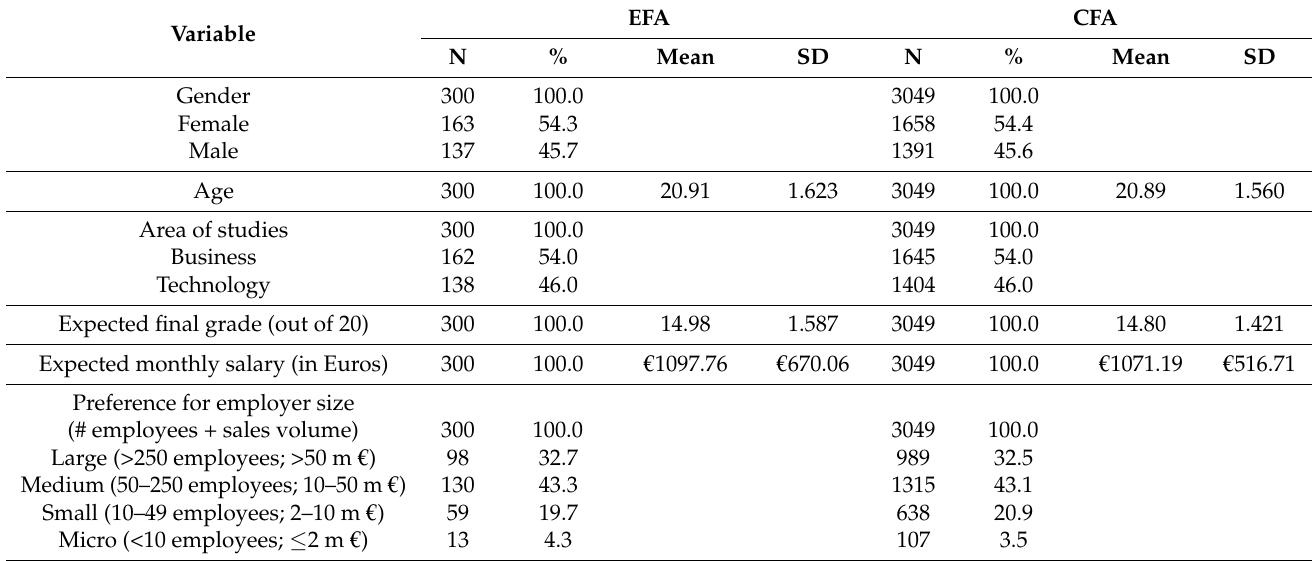
Table 3. Descriptive statistics of respondents and job preferences for EFA and CFA